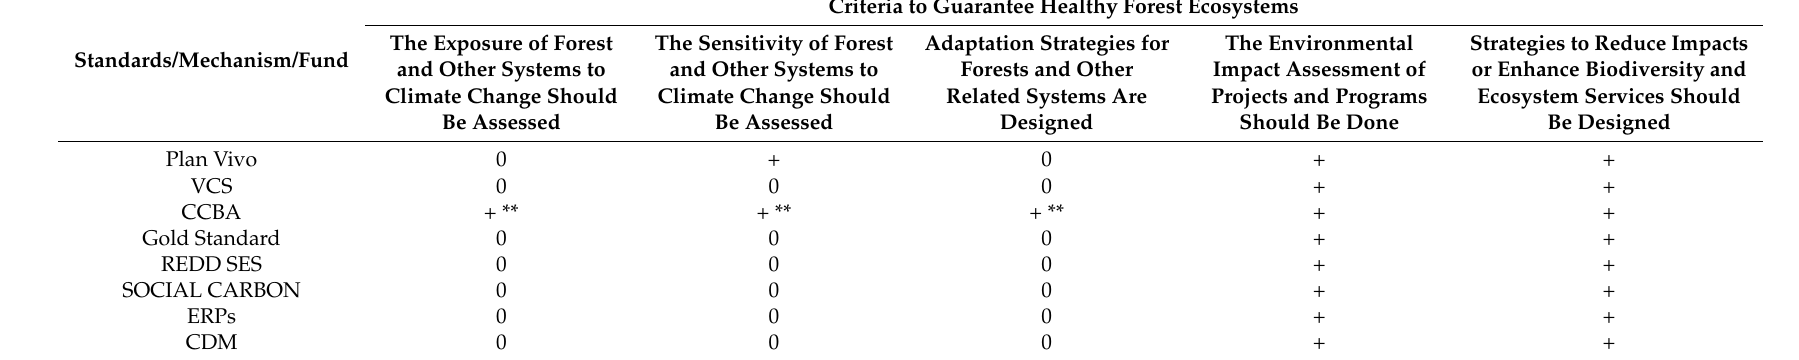
Table 2. Assessing the guarantee of healthy forest ecosystems in the guidelines for developing forest carbon initiatives.